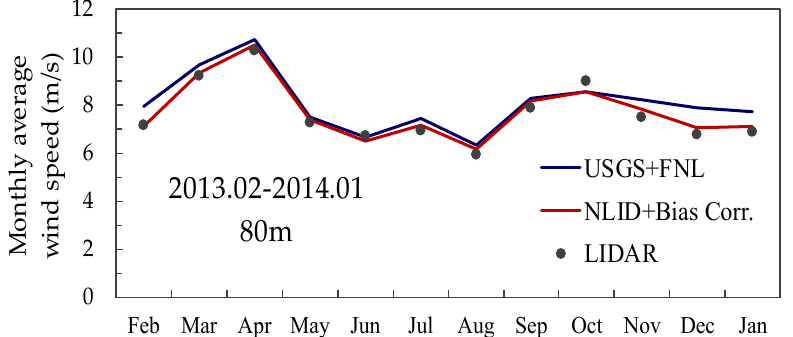
Figure 15. Monthly averaged wind speed at the hub height of 80 m. Table 8. Classification of atmospheric stability according to Monin-Obukhov length intervals.